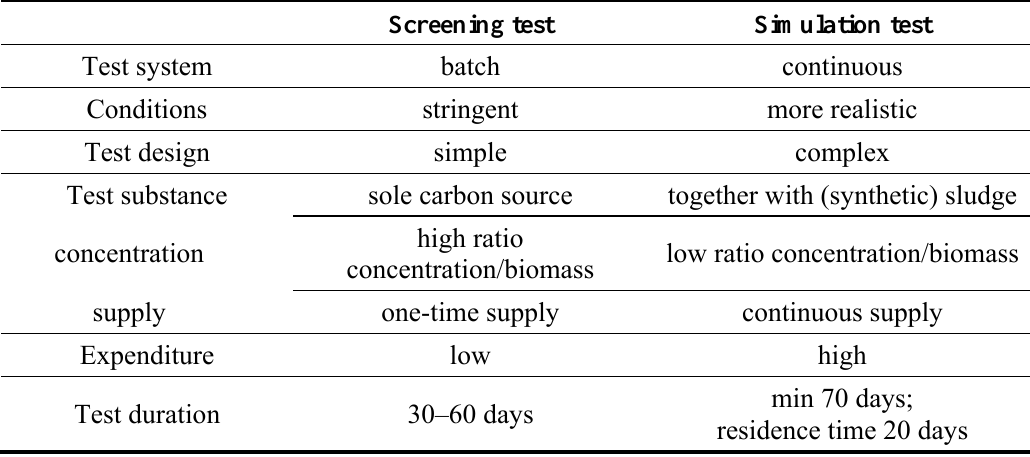
Table 1 . Characteristics of screening and simulation test